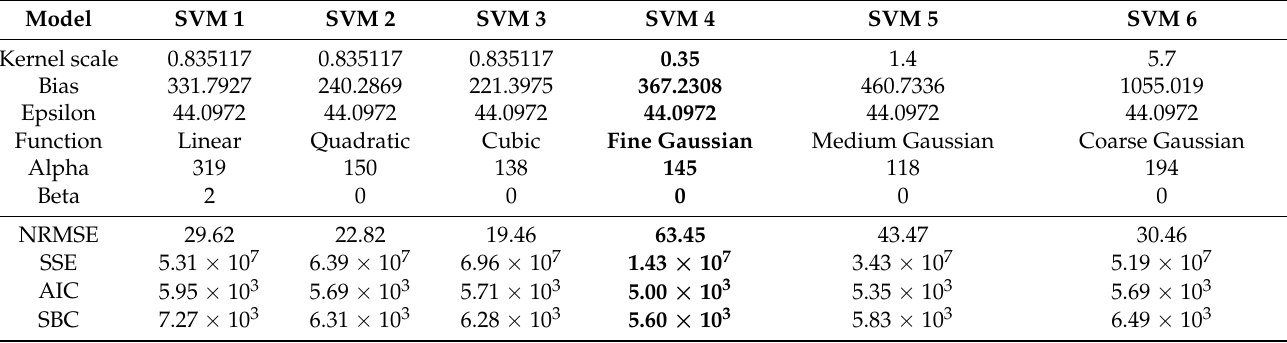
Table 10. Overview of the parameters of the created SVM models and performance metrics of the DMSP-20 muscle validation results.